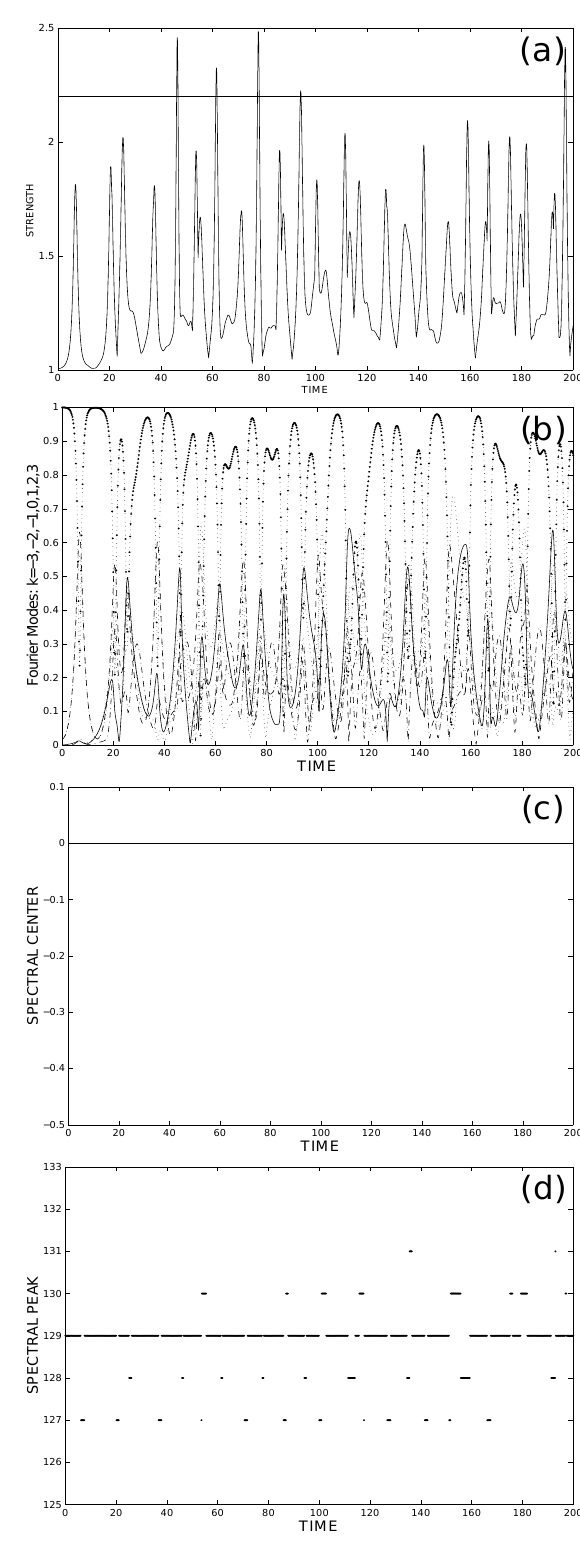
Fig. 5: The HONLS eq., Γ = 0 , ǫ = 0 . 05 , β = 0 : time evolu- Fig. 5. The HONLS equation, 0 = 0, (cid:15) = 0 . 05, β = 0: time evolution of (a) the strength S(t) , (b) the main Fourier mode, (c) tion of (a) the strength S ( t ) , (b) the main Fourier mode, (c) the spectral center k m , and (d) the spectral peak k peak the spectral center k , and (d) the spectral peak k . m peak